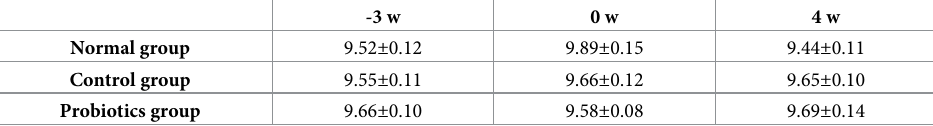
Table 13. The effect of probiotics treatment on serum calcium concentration (mg/dL) in adenine-induced CKD rats. -3 w 0 w 4 w Normal group Control group 9.69 ± 0.14 The normal group (N = 20) was untreated. The control group (N = 20) and the probiotics group (N = 20) received adenine orally from Week -3 to Week 0 to induce CKD. The control group received PBS orally from Week 0 to Week 4. The probiotics group received probiotics dissolved in PBS orally from Week 0 to Week 4. When the Bartlett